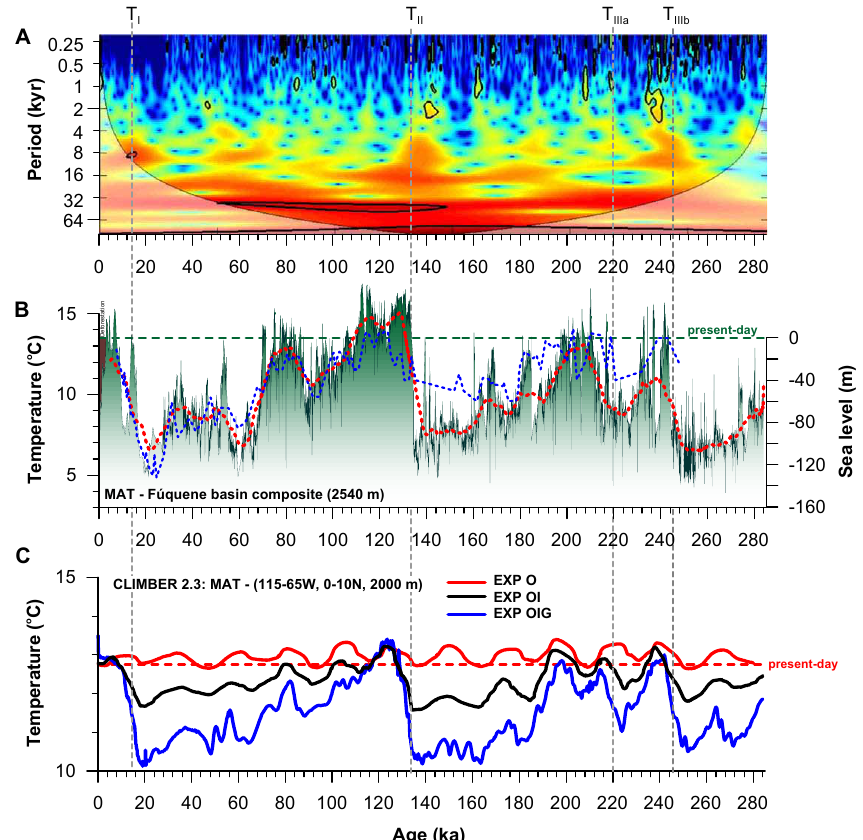
Fig. 7. Wavelet analysis of the Lake F´uquene arboreal pollen percentages (AP%) record (A) and comparison between the reconstructed (B) and modeled (C) mean annual temperatures (MAT) for the gridbox (115 ◦ W–65 ◦ W; 0–10 ◦ N) at an altitude of 2000m. Red dotted line in (B) indicates 10kyr moving average, while the blue dotted line represents the radioisotopical dated coral-based sea level reconstructions (Thompson and Goldstein,